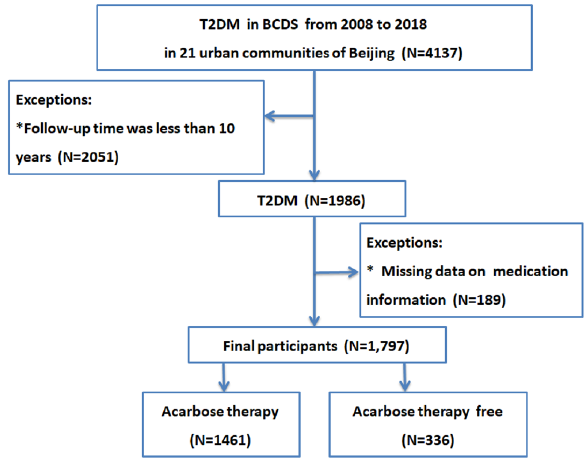
Figure 1. Flow chart showing the number of study